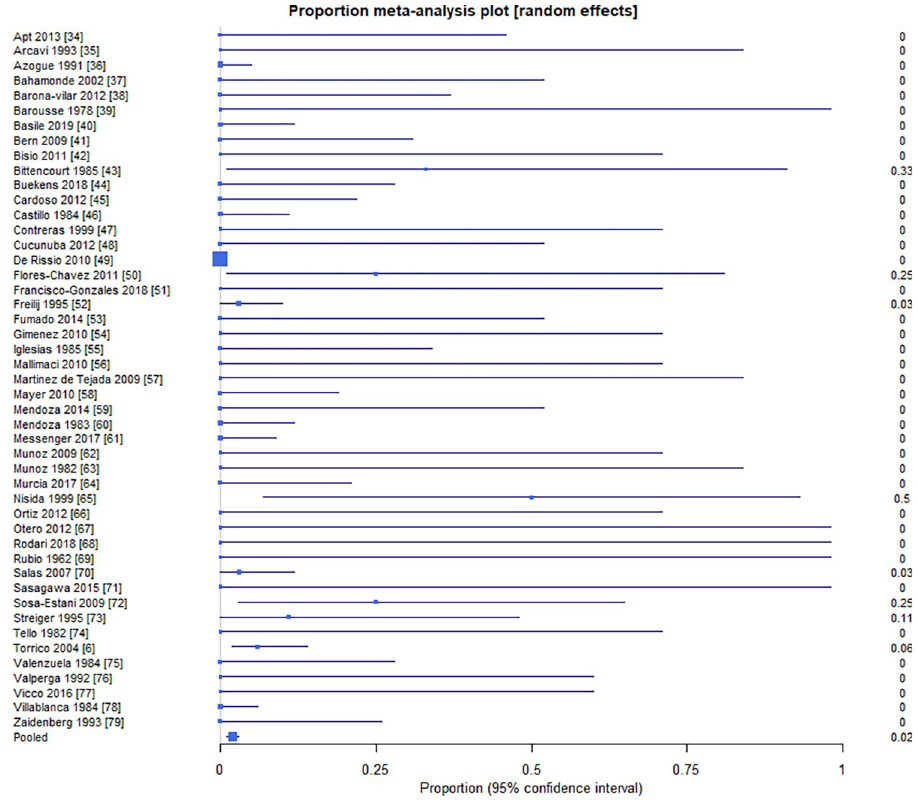
Fig 3. Proportion of infants with cCD who experience mortality by study